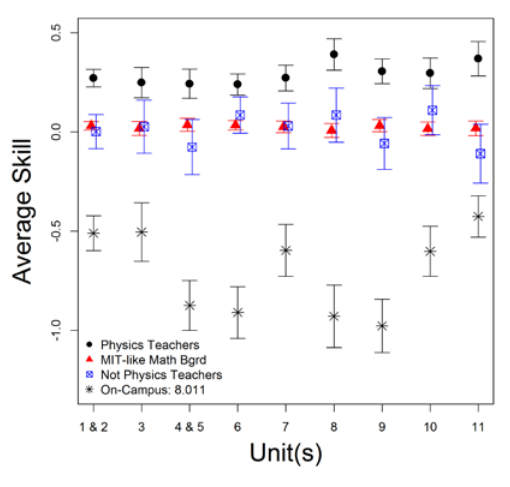
Figure 6 . Weekly performance of various cohorts in 8.MReV compared with on-campus students in 8.011. Note: MIT-like Math Background refers to students with at least one- semester of